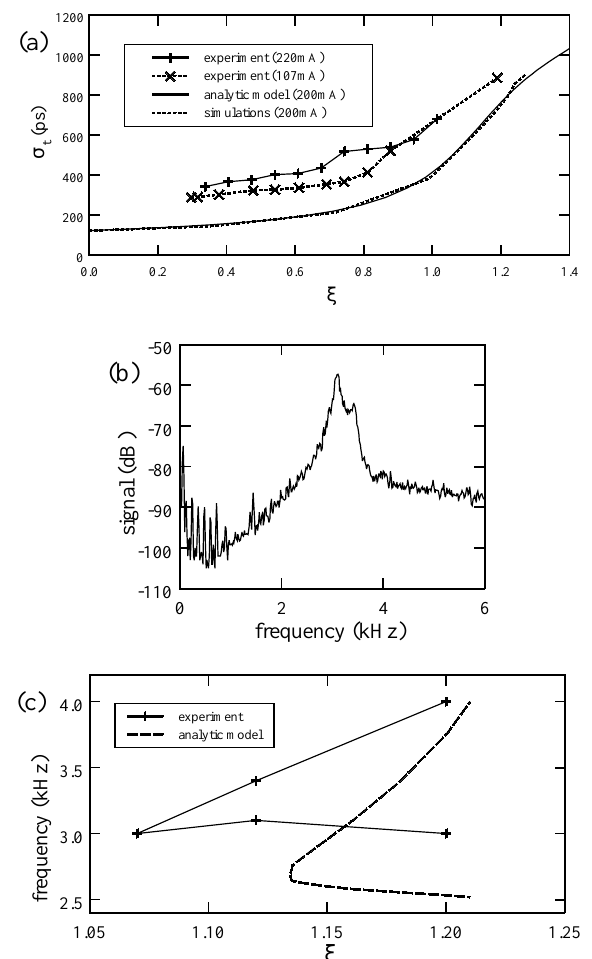
FIG. 7. (a) Bunch length determined from experiment, analytic modeling, and simulations, for passive Landau-cavity operation with the LF20 lattice. The parameter j is proportional to the Landau-cavity voltage, equaling unity for an optimally length- ened bunch. (b) Bunch oscillation signal for passive Landau- cavity operation with the LF20 lattice and a ring current of 128 mA, for a stable double-hump bunch with j (cid:1) 1.12 . Peaks are observed at 3.1 and 3.4 kHz. (c) Bunch oscillation frequen- cies observed for passive Landau-cavity operation with the LF20 lattice at a ring current of 128 mA. Instability occurs when the frequencies converge for j (cid:1) 1.07 . Analytic modeling of the coupled-dipole and coupled-quadrupole mode frequencies is also